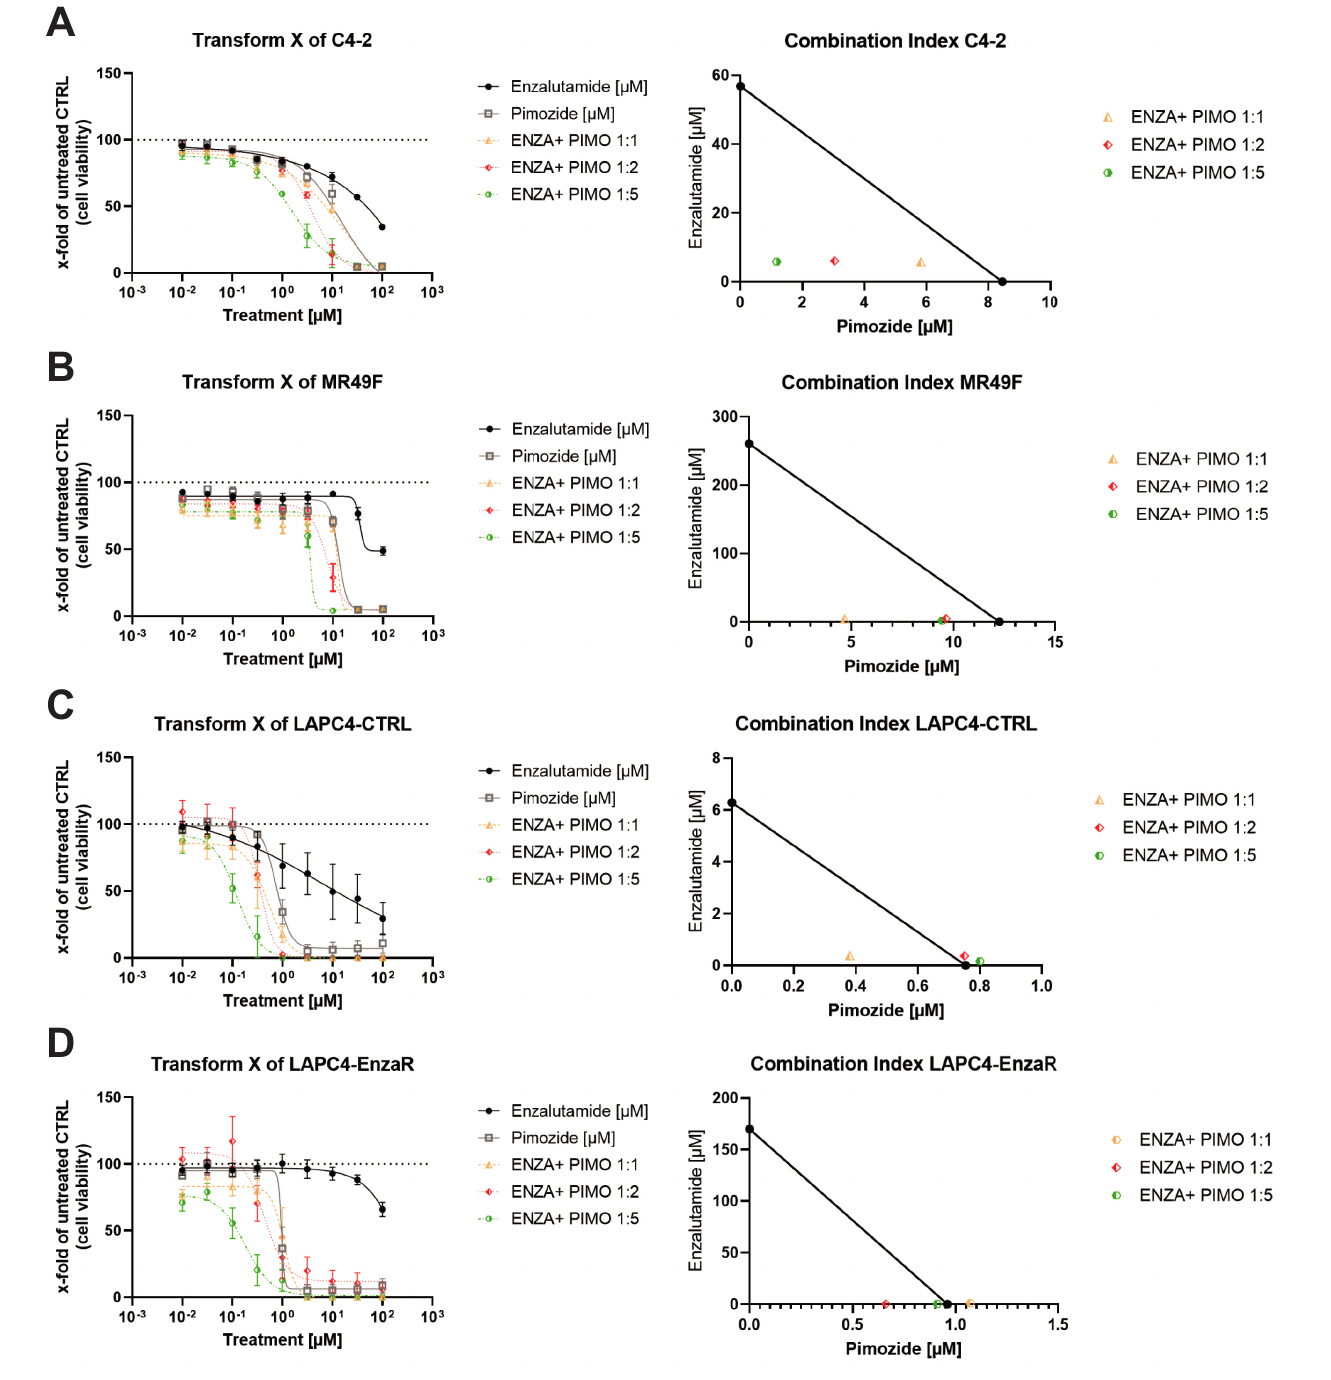
Fig 4. Isobologram analysis of combined treatment with the STAT5 inhibitor pimozide and enzalutamide. Isobologram experiments were carried out with enzalutamide and pimozide as introduced by Loewe [36]. Results of dose-response experiments and graphical illustration of the combination index (CI) in C4-2 cells (A), MR49F cells (B), LAPC4-CTRL (C), and LAPC4-EnzaR cells (D). Cell viability after enzalutamide and pimozide treatment was assessed by MTT viability assays. Data is shown as mean ± s.e.m. of three independent